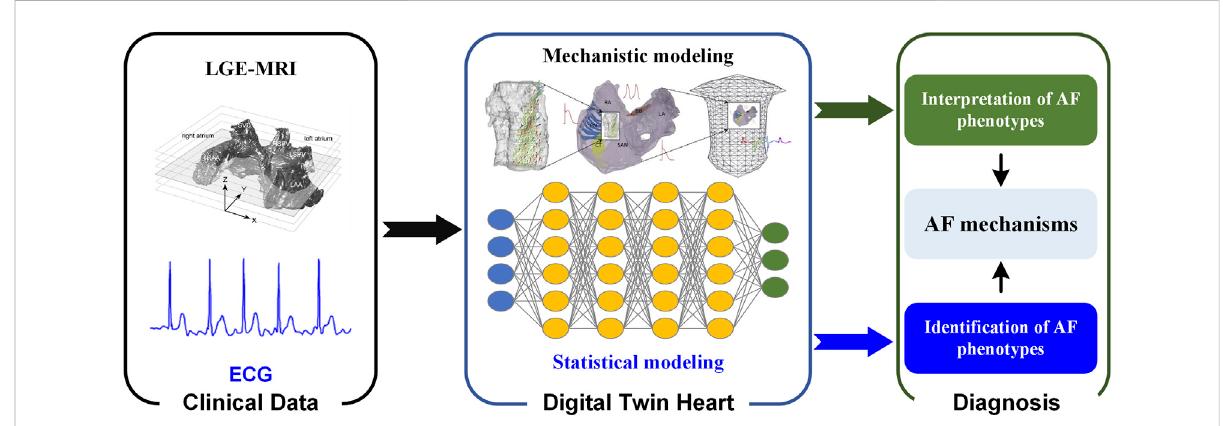
FIGURE 2 Digital twin heart in exploring the AF mechanisms. Clinical data are used to create and validate statistical and mechanistic models. Synergy betweenmechanisticandstatisticalmodelsgivesvaluableinsightthatisclinicallyinterpretedandcombinedwithtraditionaldatatoaidintheprocess of clinical